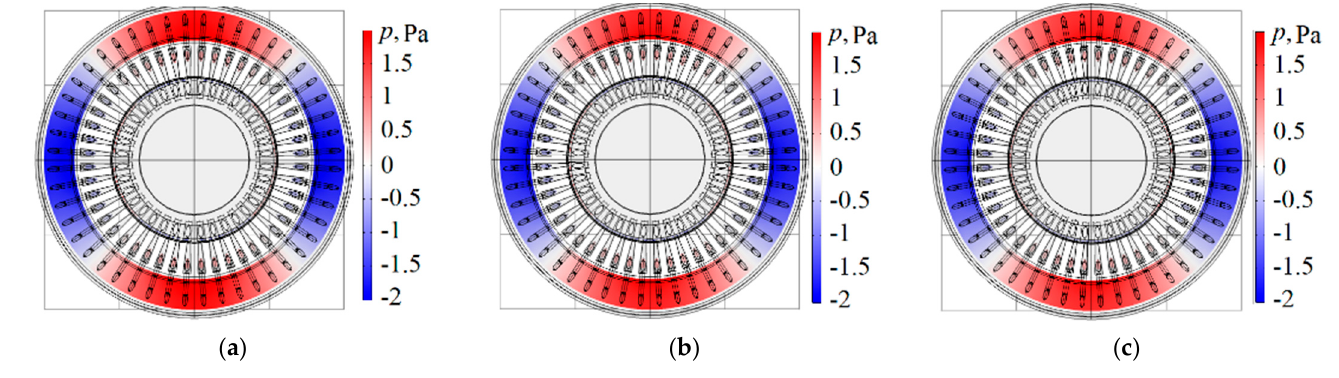
Figure 8. Acoustic radiation pressure of the investigated motor with supply voltage imbalance: ( a ) I A = I B = I C ; ( b ) I A = 1.1· I B = 0.9· I C ; ( c ) I A = 1.4 ·I B = 0.8 ·I C .